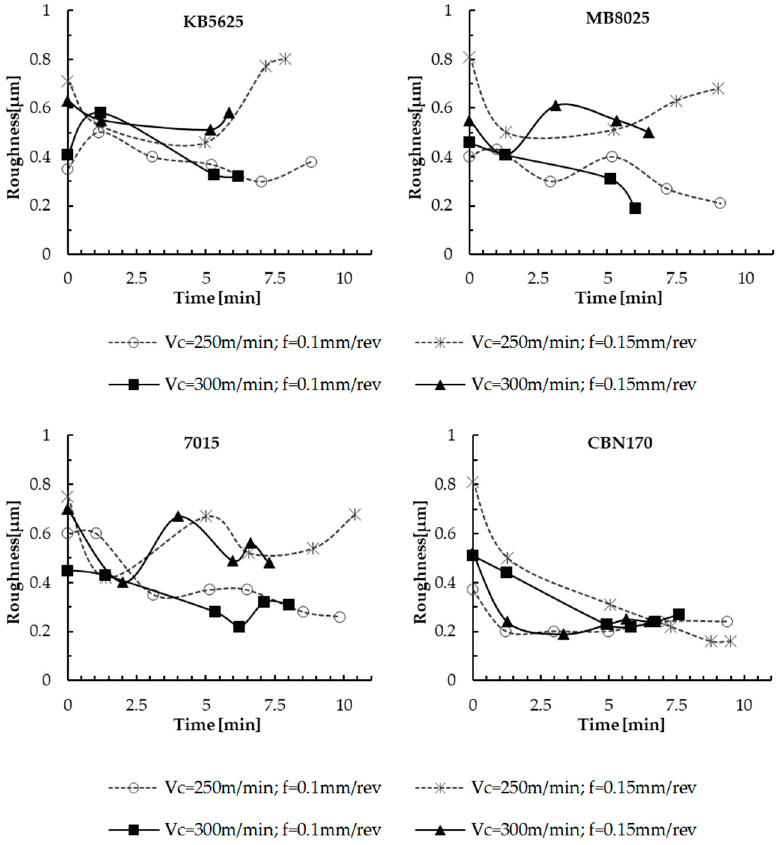
Figure 10. Average Roughness ( µ m) in PCBN